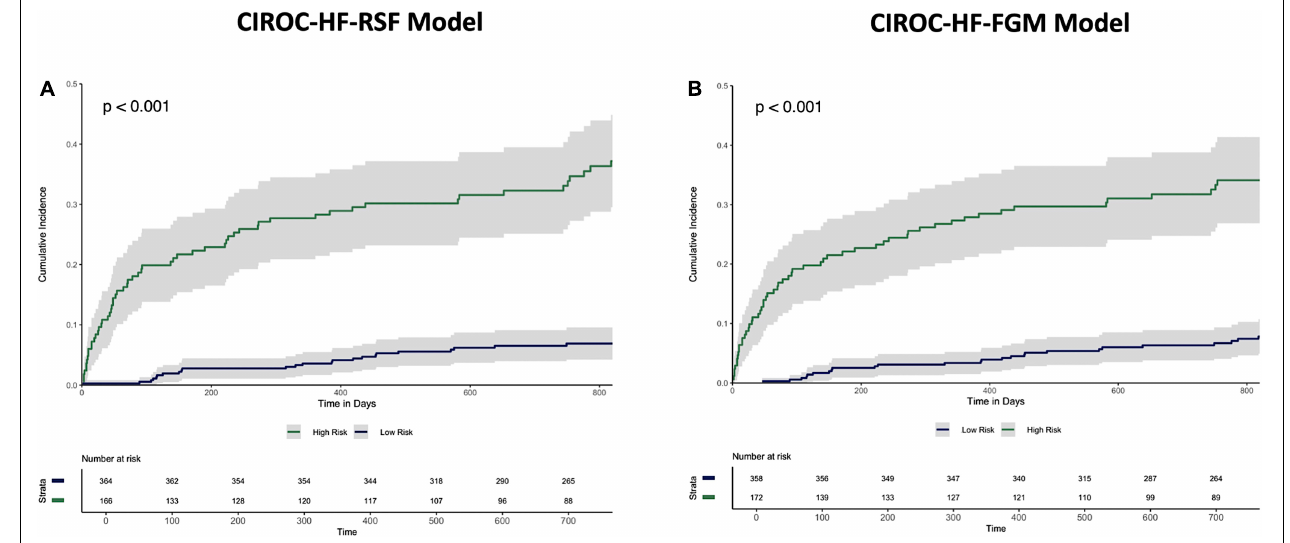
FIGURE 4 | Cumulative incidence curves describing time to HF hospitalization in the holdout dataset stratified by “High-risk” vs. “Low-risk” classification by the (A) CIROC-HF-RSF model, and (B) CIROC-HF-FGM Risk